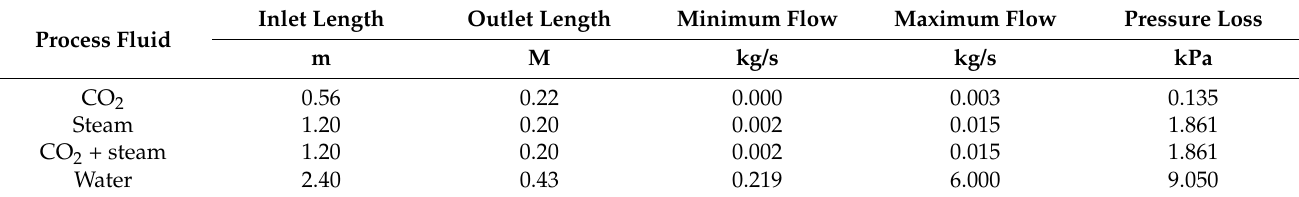
Table 6. Selected parameters of orifice